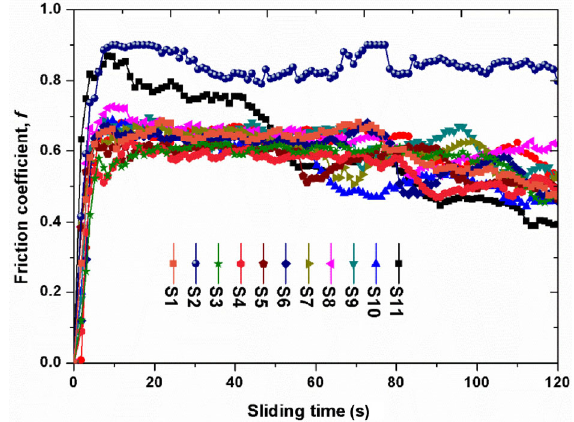
Fig. 5 Variation of f with sliding time for pin samples, S1 − S11 ( F N = 20 N, N rot = 500 rpm, sliding time = 2 min).